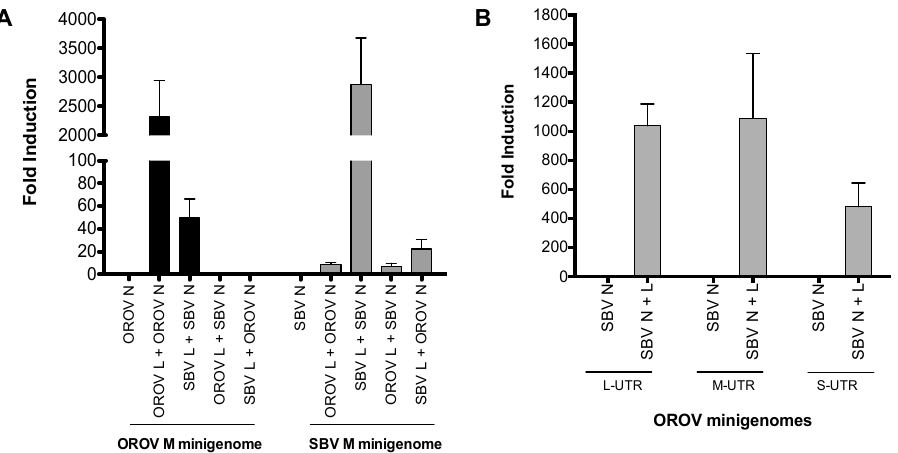
Figure 1. Minigenome activity: ( A ) BSR-T7/5 cells were transfected with pTM1-N and/or pTM1-L (250 ng) and M-minigenome (125 ng) plasmids, pTVT7R-SBVMRen(-), or pTVT7OROVMRen(-). Firefly luciferase-expressing pTM1-FF-Luc (25 ng) served as a transfection control. At 24 h post-transfection (p.t.), Renilla and firefly luciferase were measured using a Dual-Luciferase Reporter Assay kit (Promega). Luciferase values were normalized and minigenome-activity expressed as fold-induction over background control (no pTM1-L). Error bars indicate standard deviation (SD; n = 3). ( B ) BSR-T7/5 cells were transfected as previously described. 250 ng of pTM1SBV-N and/or pTM1SBV-L were transfected with 125 ng of pTVT7OROVLRen(-), pTVT7OROVMRen(-), or pTVT7OROVSRen(-), and pTM1-FF-Luc (25 ng). At 24 h p.t., Renilla and firefly luciferase were measured using a Dual-Luciferase Reporter Assay kit (Promega). Luciferase values were normalized and minigenome-activity expressed as fold-induction over background control (no pTM1-L). Error bars indicate SD ( n = 3). OROV, Oropouche virus; SBV, Schmallenberg virus; L, viral polymerase; N, nucleocapsid protein; M minigenome, medium segment analogue; L-UTR, large segment untranslated region; M-UTR, medium segment untranslated region; S-UTR, small segment untranslated